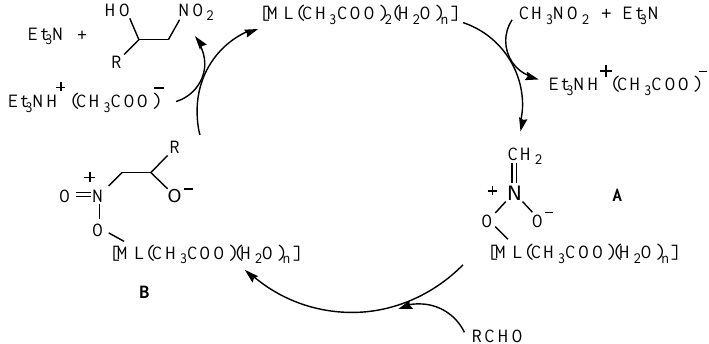
Figure 6. The possible mechanism of the Henry reaction.